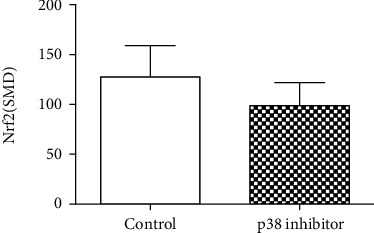
Meta-analysis of the effect of p38 inhibitor on Nrf2 in vitro. SMD: standardized mean difference. The P value of the overall effect test is 0.04. When P < 0.05, the difference was considered statistically significant.